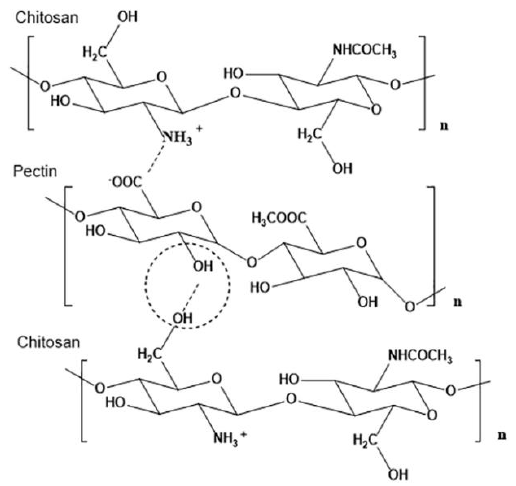
Figure 23. Physical interactions between chitosan and pectin.